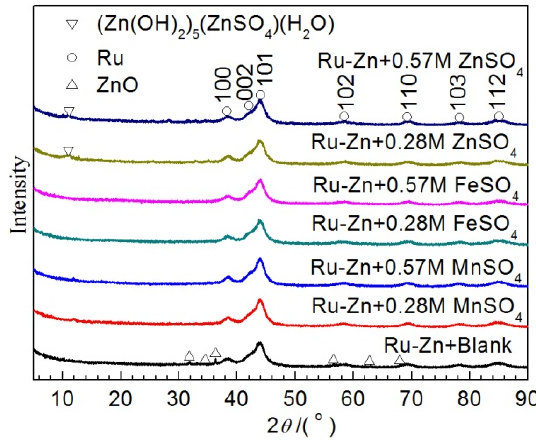
Figure 6. XRD patterns of the Ru-Zn catalyst after catalytic experiments applying different amounts of ZnSO 4 , FeSO 4, and MnSO 4 as reaction modifiers.